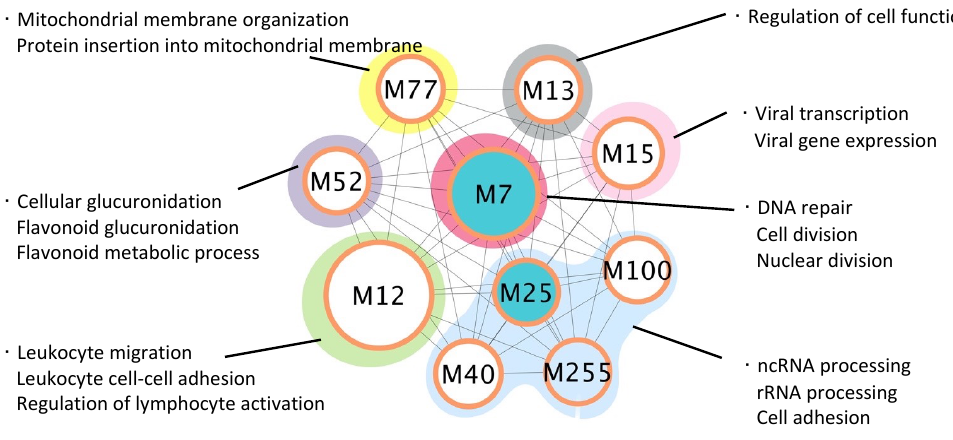
Figure 3. High-centrality functional modules in HCC cohorts. The networks were limited to modules with a minimum number of 20 nodes and a connectivity coefficient larger than 0.5. ( A ) and ( B ) showed the modules identified in LIHC and LIRI-JP cohort, respectively. The prognostic attributes of modules were marked by different color, as shown in legend. Modules with similar biological functions were circled with same background color (red—DNA replication, green—Immune response, purple— Metabolic process, yellow—Mitochondrial process, blue—RNA-related process, pink—Virus infection and gray—Other functions). Top biological processes were listed beside the functional circle for detailed